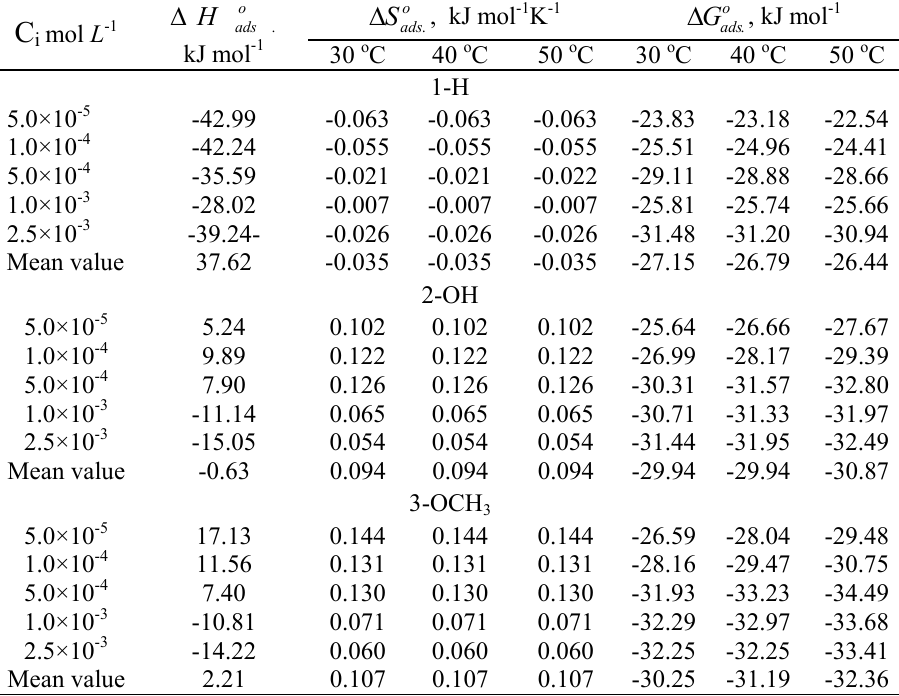
Table 4. Thermodynamic adsorption parameters of the studied organic cations onto Dowex 50WEX/H +